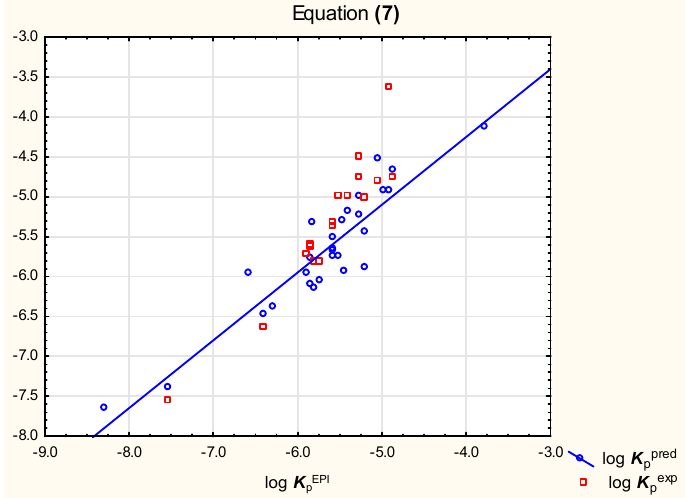
Figure 2 . Equation (7)—predicted and experimental log K p vs. reference values . Figure 2. Equation (7)—predicted and experimental log K